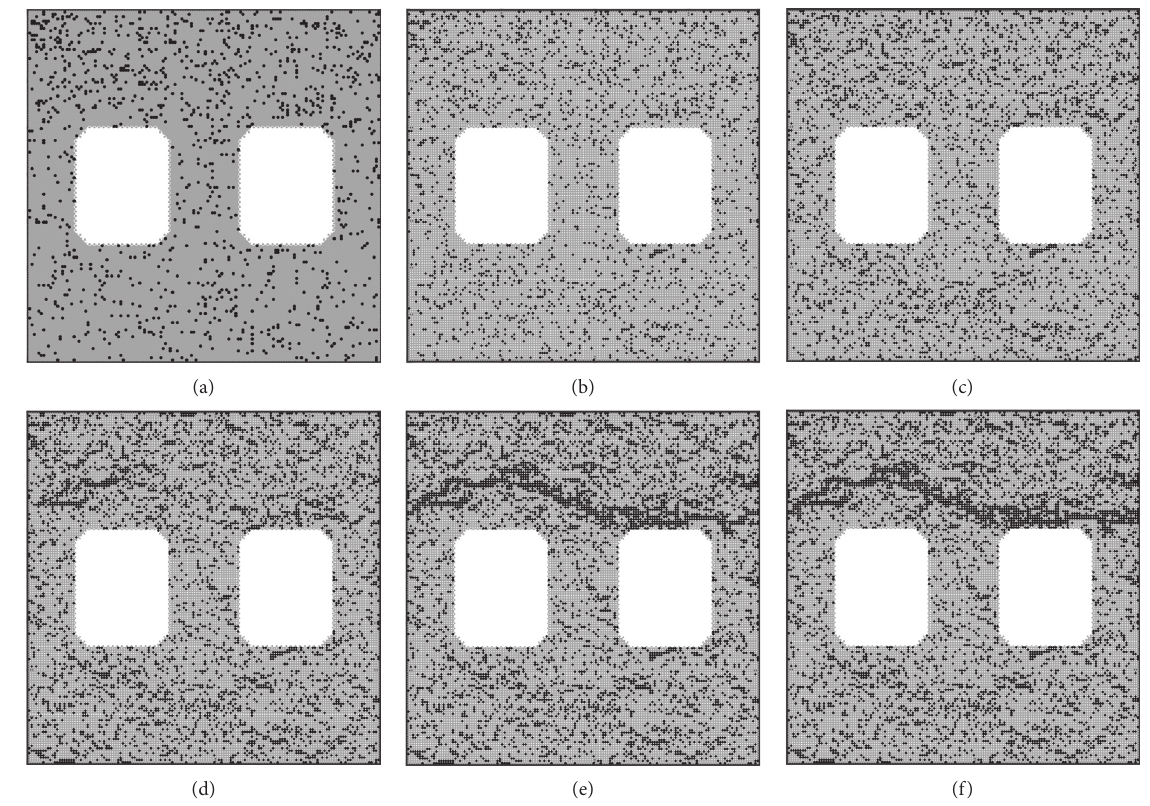
Figure 10: Mesoscale damage evolution process of the double-aggregate specimen under uniaxial tension. White and light-gray colors represent aggregates and mortar matrix, respectively, and dark-gray and black colors denote shear failure and tension failure, respectively.